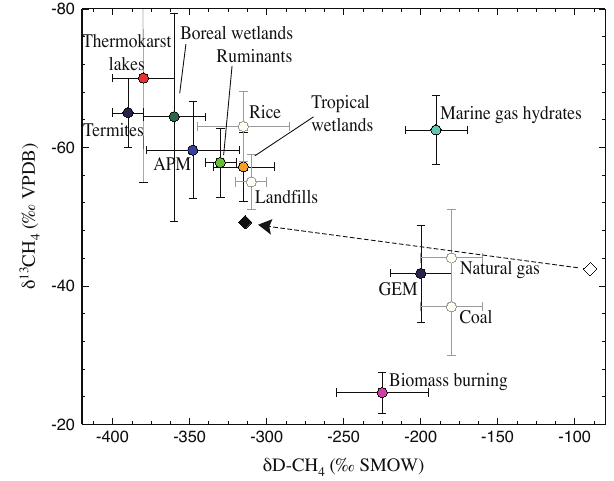
Fig. 7. Combination of characteristic δ 13 CH 4 and δ D-CH 4 signa- tures for the major primary sources of methane to the troposphere, together with the calculated mean source isotope values of the ad- ditional emissions ( δ 13 CH 4 ↑ T , δ D-CH 4 ↑ T ) [black diamond] as derived from the ice core signal [white diamond] (Tables 1 and 2). Unfilled circles are anthropogenic